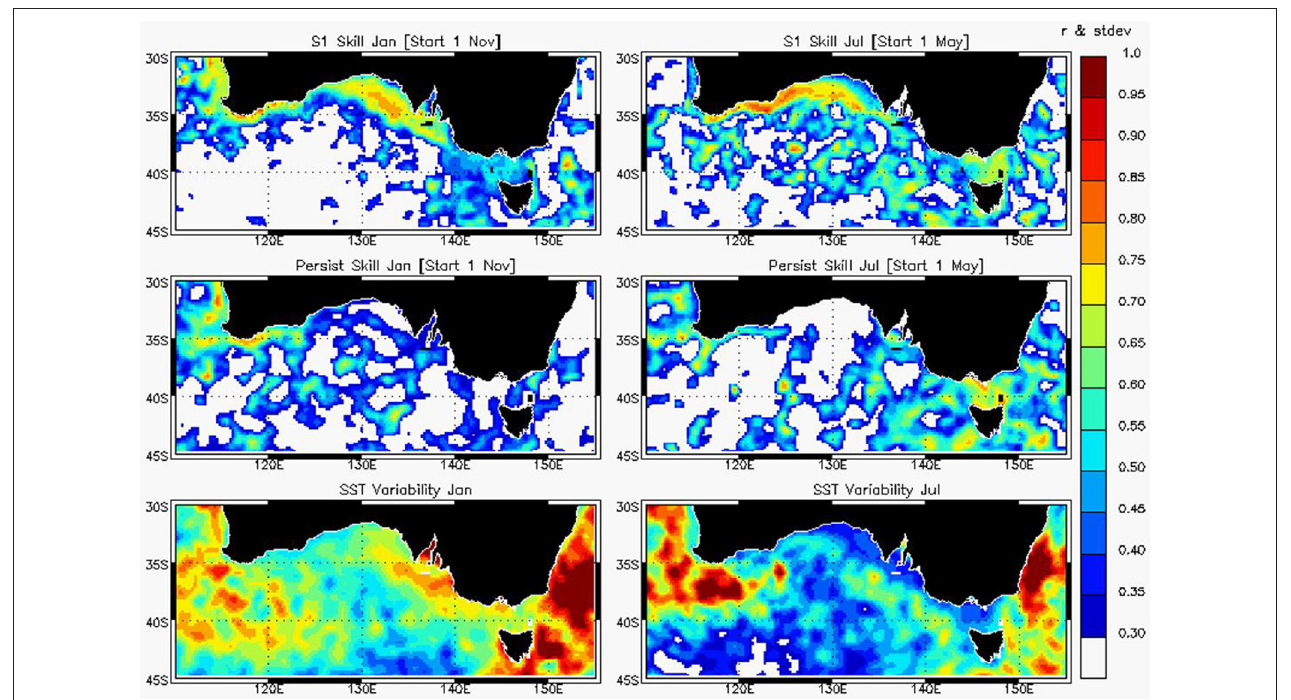
FIGURE 5 | Skill of alternative seasonal forecast approaches in summer (January) and winter (July), illustrated for southern Australia. Row 1 : skill for ACCESS-S1 forecasts issued 1 November and 1 May; Row 2 : skill for persistence forecasts issued 1 November and 1 May; Row 3 : inter-annual SST variability for January and July (standard deviation for January or July across 1991–2012). In all cases, values were calculated over the time period 1990–2012.